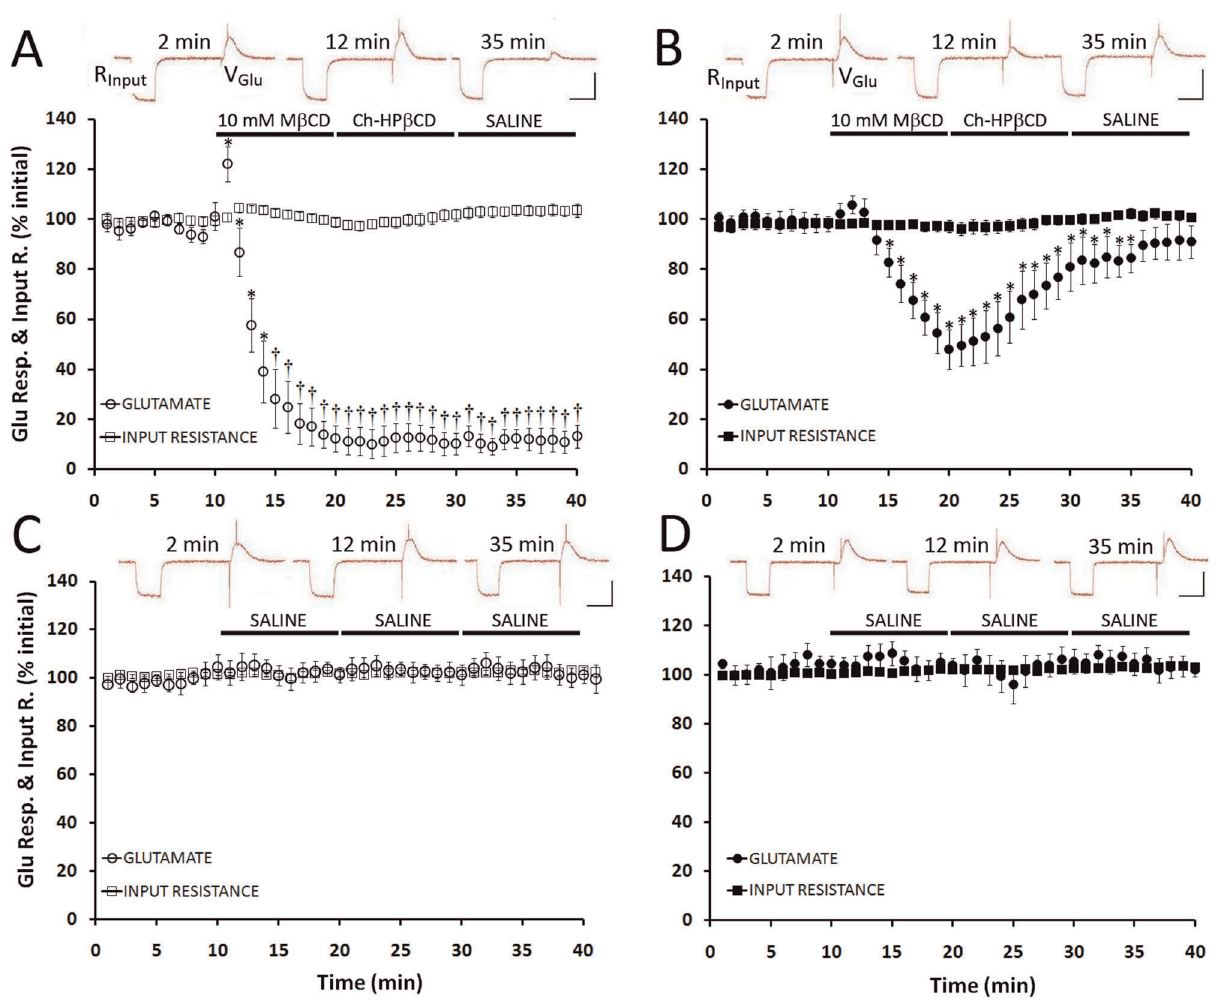
Figure 4. M b CD alters postsynaptic responsiveness. Intracellular voltage recordings were made from L1 muscle fibers within segment IV while iontophoretically applying L-glutamate and simultaneously injecting hyperpolarizing current intracellularly. These recordings detected changes in input resistance of muscle fibers as well as any changes in postsynaptic receptor sensitivity. Under no conditions was there an effect on the input resistance of muscle fibers (open and closed squares). A . Cold-acclimatized group (open symbols). Responsiveness to iontophoretically applied glutamate (open circles) revealed a significant (P , 0.05) transient increase following the application of 10 mM M b CD, that subsequently resulted in a 17%/min reduction in the sensitivity to applied glutamate which plateaued within 6 min. Attempts to recover responsiveness, using a cholesterol- loaded cyclodextrin (Ch-HP b CD) and a saline wash, were unsuccessful. B . Warm-acclimatized group (closed symbols). While there was no immediate change in responsiveness to applied glutamate (closed circles), a subsequent gradual reduction during exposure to M b CD occurred. Application of Ch-HP b CD recovered responsiveness to 90% of initial values, and a subsequent saline wash resulted in a return to control values. C-D . Control recordings from cold- and warm-acclimatized groups were stable throughout the 40min recording period. Insets: recordings of input resistance and responsiveness to iontophoretically applied glutamate at selected time points. * indicates P , 0.05, { indicates P , 0.01. N=7. Scale bars: 15 mV, 250 ms.